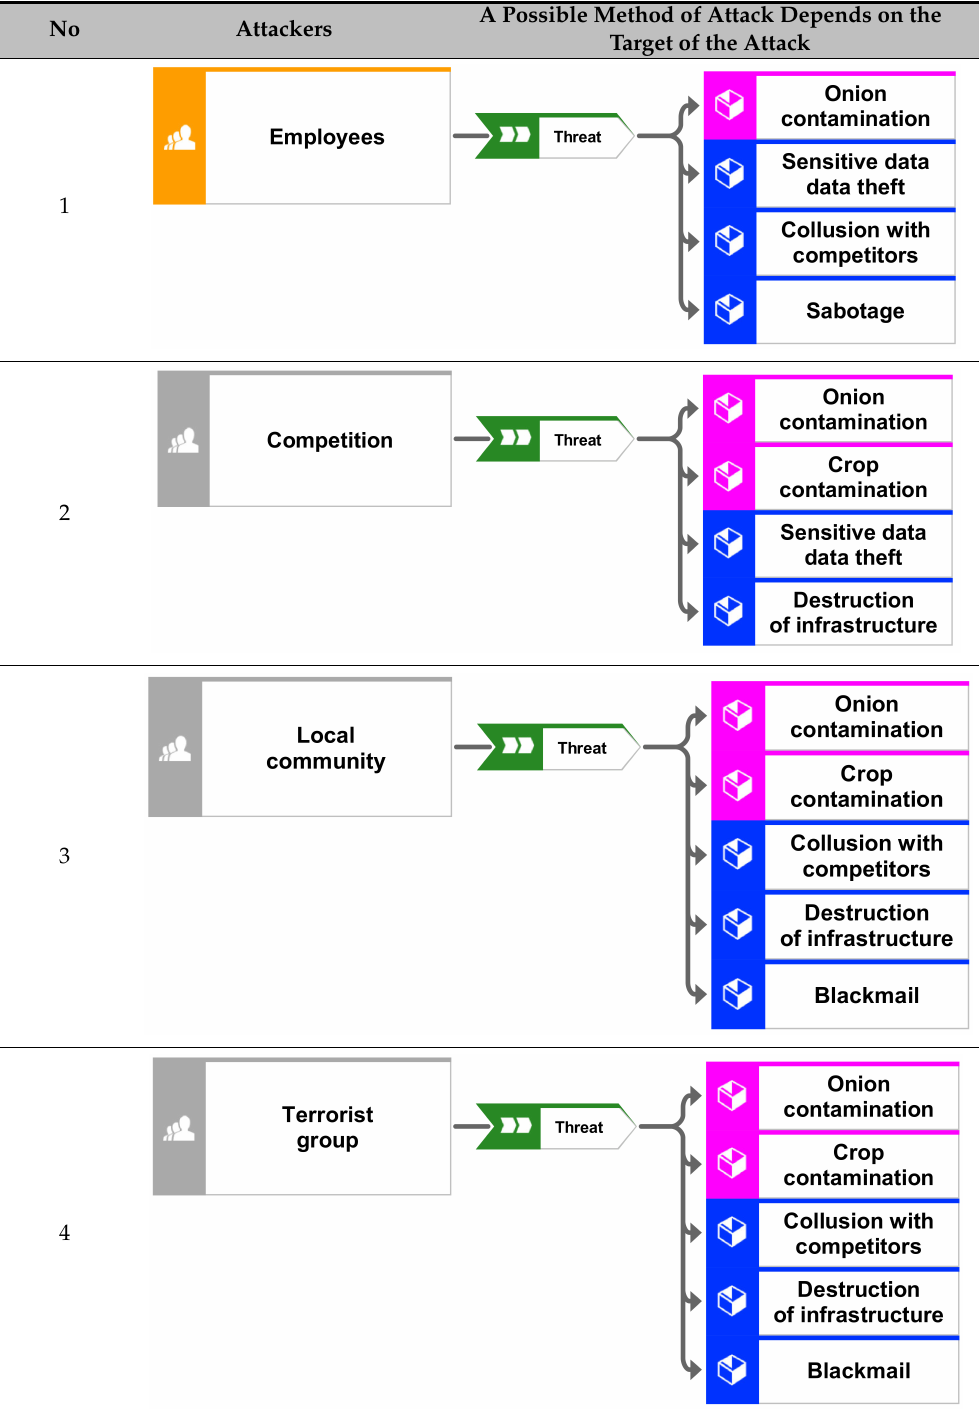
The evaluation results for CARVER+Shock are presented in Table